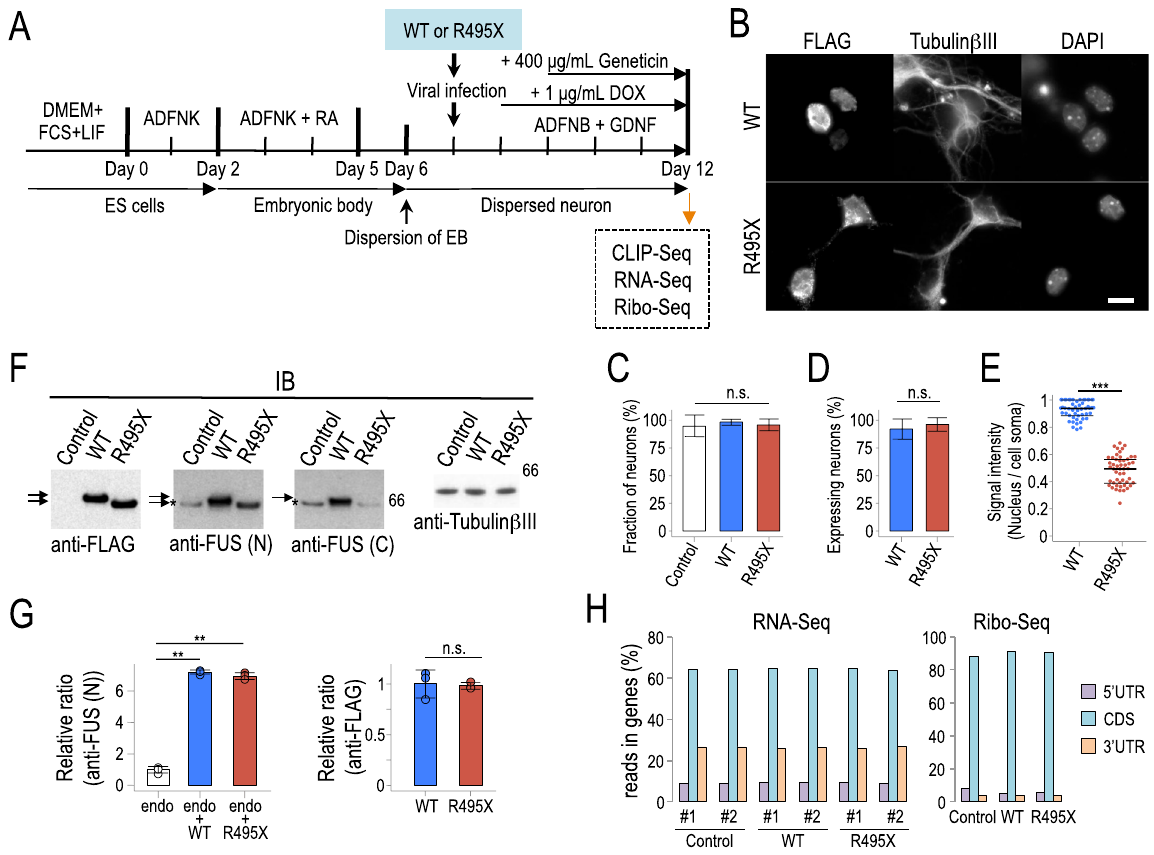
Figure 1. CLIP-Seq, RNA-Seq and Ribo-Seq on human FUS WT- or R495X-expressing neurons. ( A ) Schematic of the experimental design for CLIP-Seq, RNA-Seq and Ribo-Seq library preparation from mouse ES cell derived neurons. ( B ) Immunostaining for cellular localization of NFLAG-hFUSWT (WT) and NFLAG- hFUSR495X (R495X) in neurons. Anti-FLAG (left), anti-Tubulin β III (middle) and DAPI stain (right) are shown. Scale bar, 10 μ m. ( C ) Bar plot for fraction of neurons over all cells for Control, WT- and R495X- expressing cells. Error bars indicate standard deviation (N = 18). n.s., not significant ( p = 0.253), one-way ANOVA test. ( D ) Bar plot for percentage of neurons expressing WT and R495X. Error bars indicate standard deviation (N = 18). n.s., not significant ( p = 0.115), two-tailed Student’s t -test. ( E ). Beeswarm plot for ratio of nuclear localization of WT and R495X in neurons. Ratio represents fluorescence intensity in the nucleus over cell soma. N = 50. *** p = 2.83 × 10 − 40 , two-tailed Student’s t -test. Black bars represent median, 25th and 75th percentiles. ( F ) Immunoblots showing expression levels using the indicated antibodies for FLAG, amino- (FUS(N)) and carboxyl-terminal FUS (FUS(C)) and Tubulin β III. Arrows and asterisk indicate exogenous and endogenous FUS proteins, respectively. Protein standard is shown on the right. ( G ) Quantification of endogenous (endo) and exogenous WT and R495X FUS proteins detected by anti-FUS (N) (left) and anti-FLAG (right). N = 3. ** p < 0.0001 one-way ANOVA and p < 0.01 in post Tukey’s HSD test for left graph. n.s., not significant ( p = 0.827) two-tailed Student’s t -test for right graph. ( H ) Distribution of gene mapping reads in the 5 ′ UTR, coding sequence (CDS) and 3 ′ UTR for RNA-Seq and